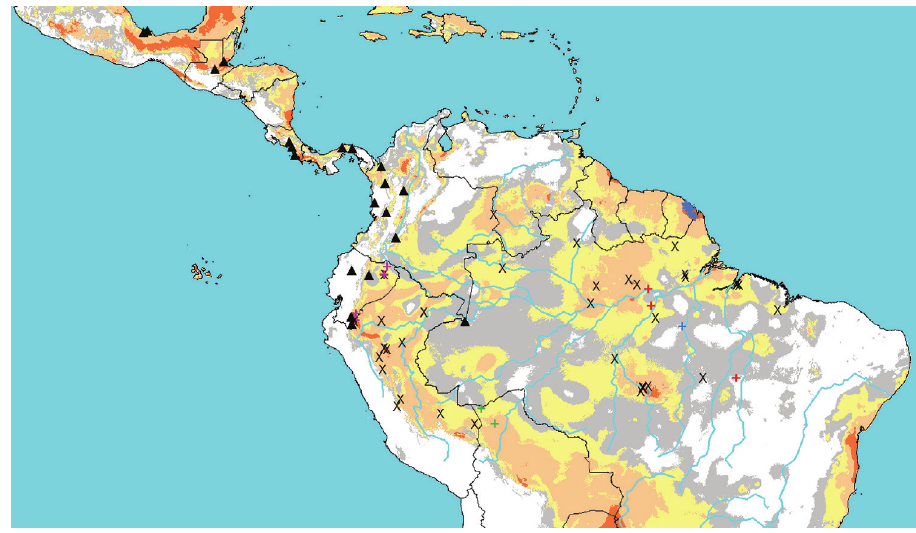
Figure 2. Distribution of examined specimens of P. riparia (X), P. emiliae (red cross), P crenata (blue cross), P. fernandezii (green cross), P. pergrandis (purple cross), and the bioclimatic distribution model, highlighting climates that are marginal (grey), favorable (light yellow), very favorable (light orange) or excellent (bright orange). Black triangles represent distribution of examined specimens of P. ambigua